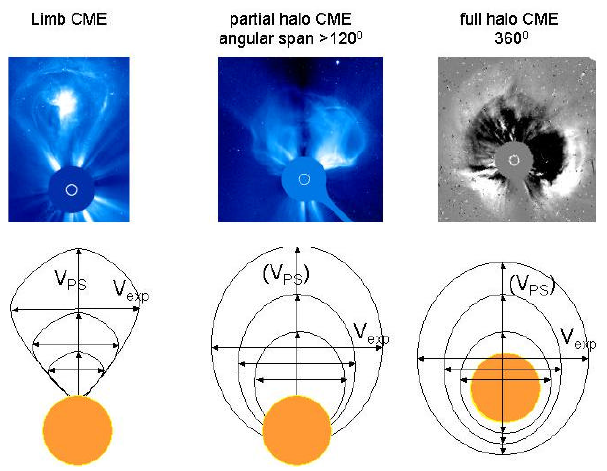
Fig. 6. The drawings illustrate how the expansion speed V exp is defined. It can be determined uniquely for all types of CMEs, be it limb, partial halo or full halo CMEs, while the apparent plane of the sky speed V PS often contains an unknown speed component towards the observer.